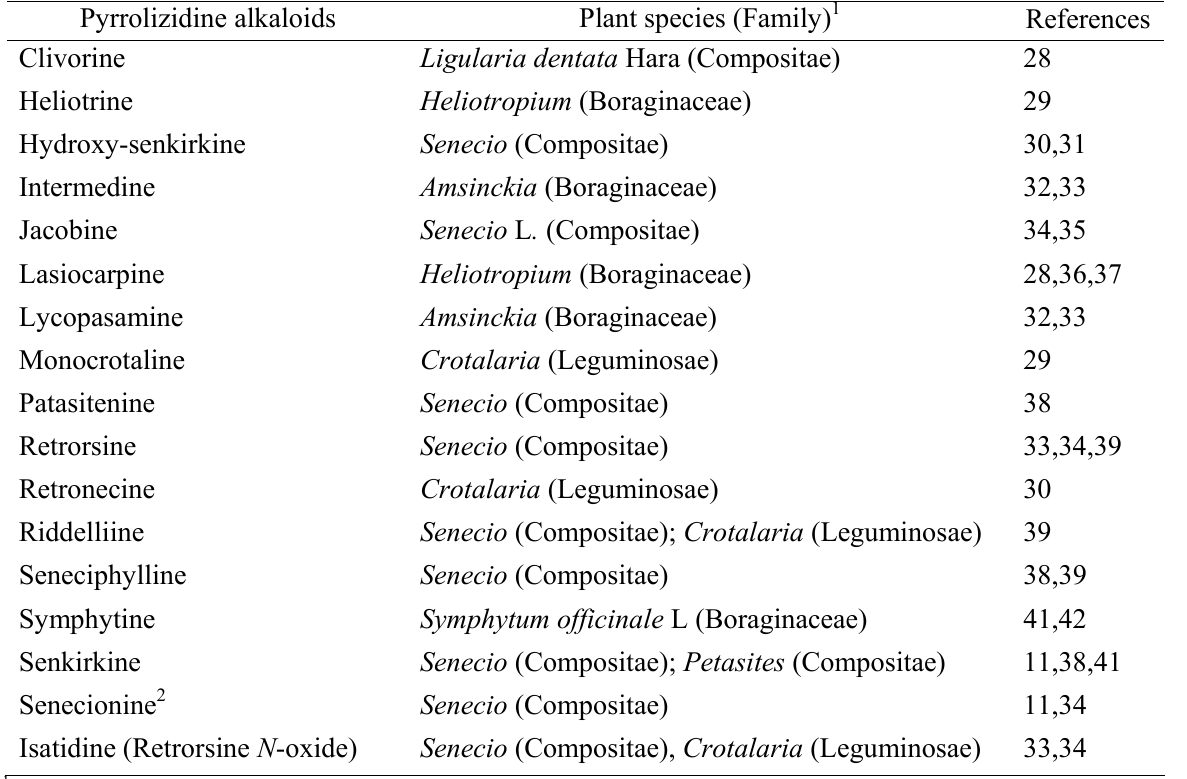
Table 1. Pyrrolizidine alkaloids that induce tumors in rats Pyrrolizidine